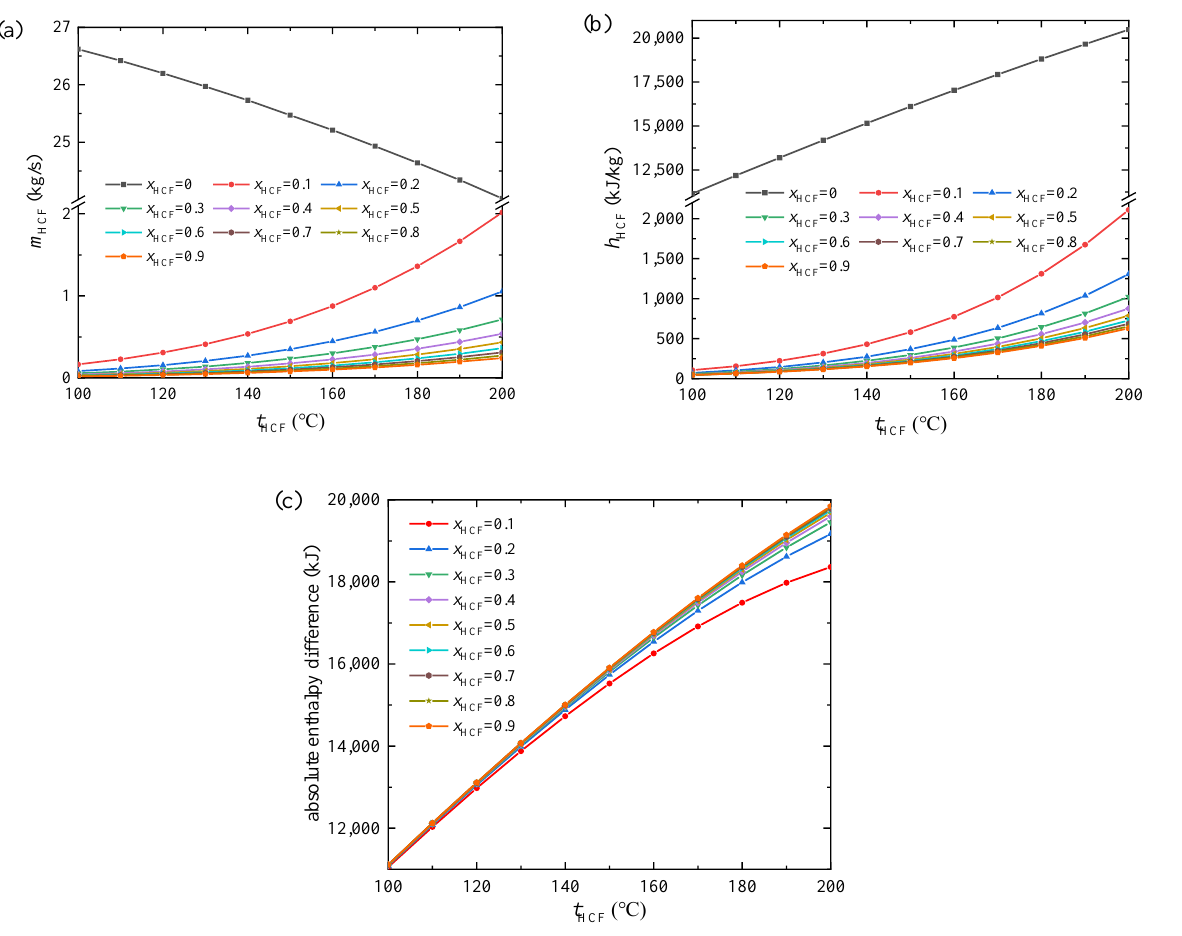
Figure 4. Variation curves of production capacity parameters of heat carrier with t HCF under the different steam quality: ( a ) mass flow rate, ( b ) enthalpy and ( c ) absolute enthalpy difference.